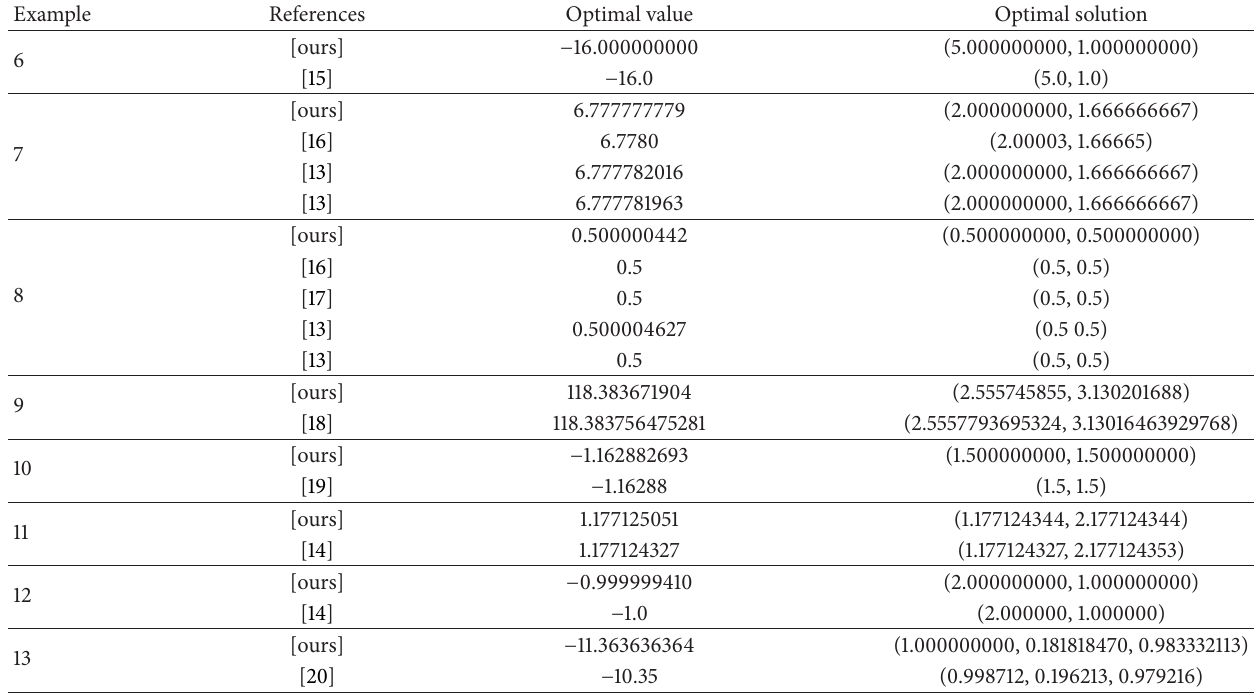
Table 1: Numerical results for the test Examples 6–13.